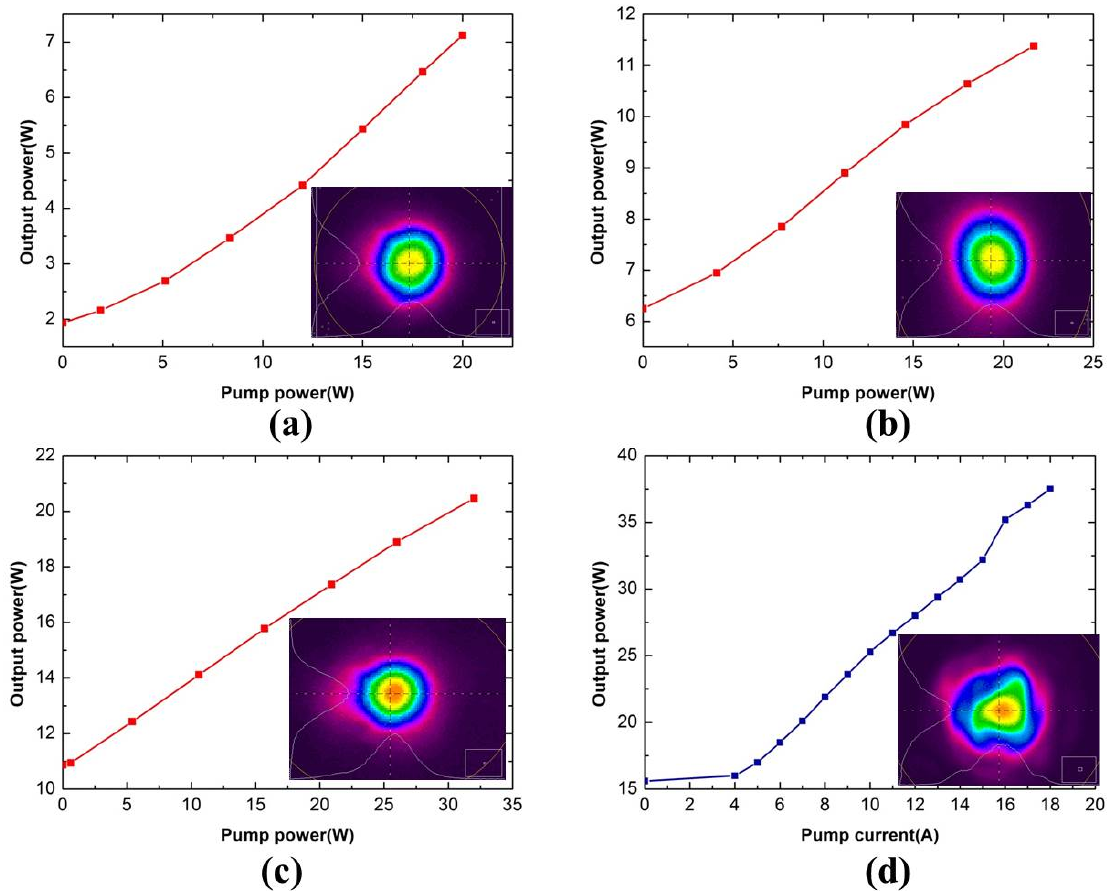
Figure 12. Power curves and beam images of each stage. ( a ) First stage; ( b ) second stage; ( c ) third stage; ( d ) side-pumped